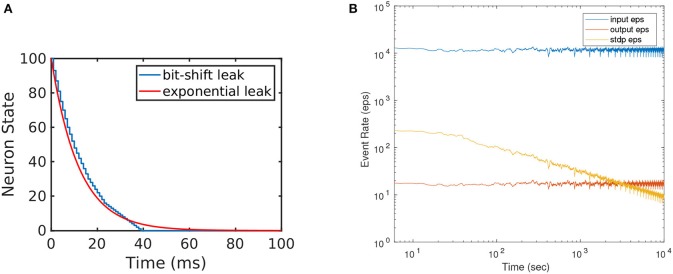
(A) Illustration of the implemented efficient leakage mechanism by using bitwise shift. This approximates exponential leakage in LIF neurons. (B) Event rate of input, output, and STDP output during STDP learning. Horizontal axis (time) is shown in log scale to visualize the exponential decay in STDP output events. One training set trial is about 400 s.